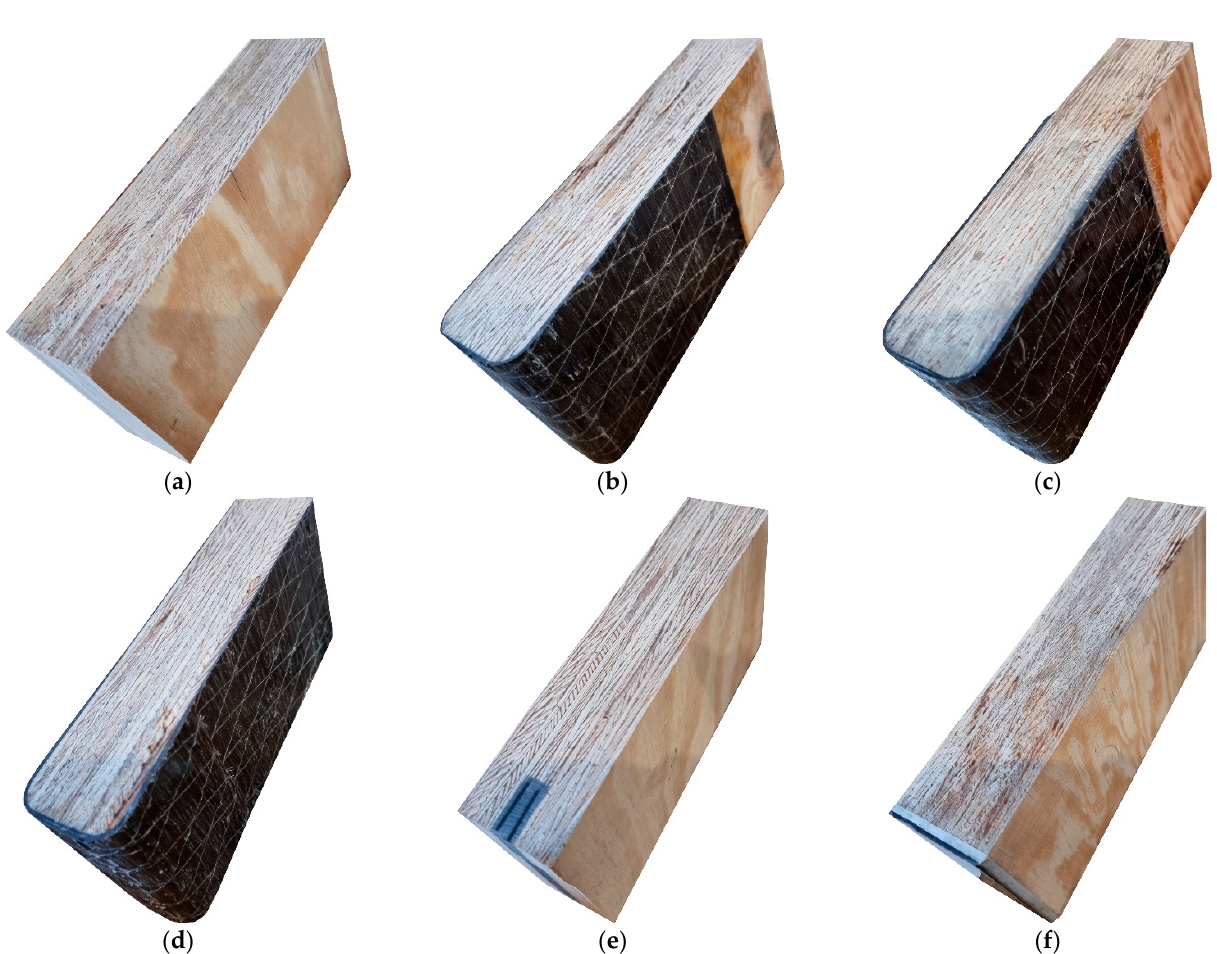
Figure 7. Views of cross-sections of tested beams for series: ( a ) A; ( b ) B; ( c ) C; ( d ) D; ( e ) E; ( f ) F. The beams were symmetrically loaded with two concentrated forces. The span of the beams in the axis of supports was 3000 mm. The distance between the concentrated forces was 1200 mm. The distance from the support axis to the axis of the nearest concentrated force was 900 mm. The load was controlled by the shift speed of the loading pressures—a speed of 7 mm/min was applied. The initial load was 0.3 kN in each actuator. Steel guide plates of 100 mm width were applied in the point of applying the concentrated force and on the supports. The static diagram of the test stand is shown in Figure 8.